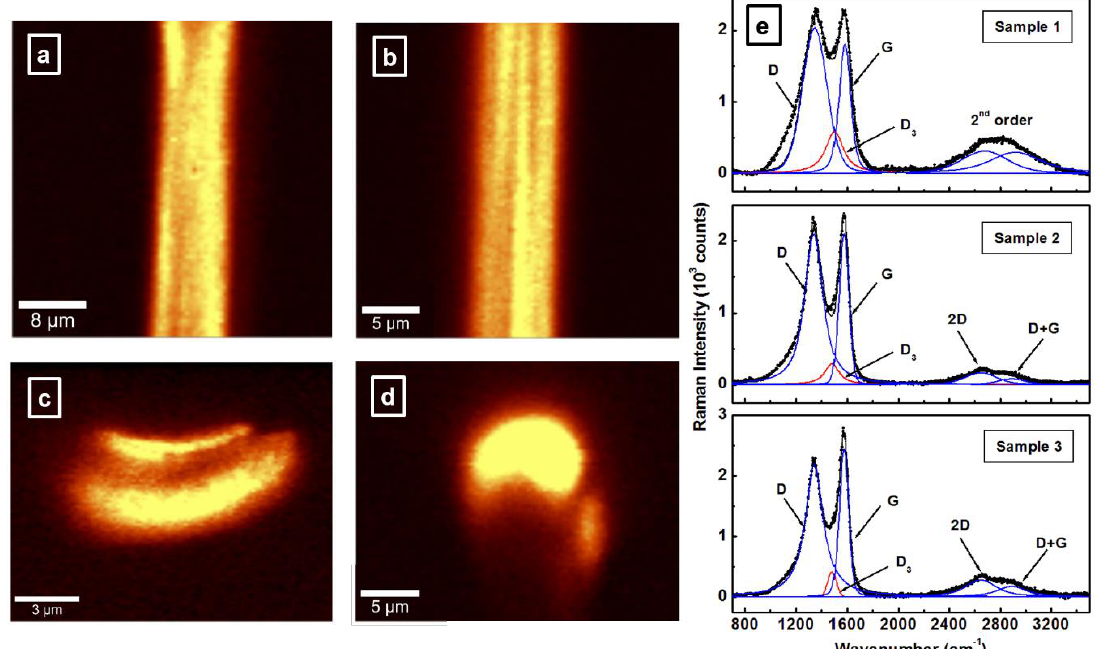
Figure 4. ( a , b ) Surface confocal Raman mapping images of samples 1 and 3, respectively. ( c , d ) Cross-sectional confocal Raman mapping images of samples 1 and 3, respectively. ( e ) Integrated Raman spectra of the three samples, as labeled. For clarity of vibrational assignments, the spectra were deconvoluted with Lorentz fitting lines.